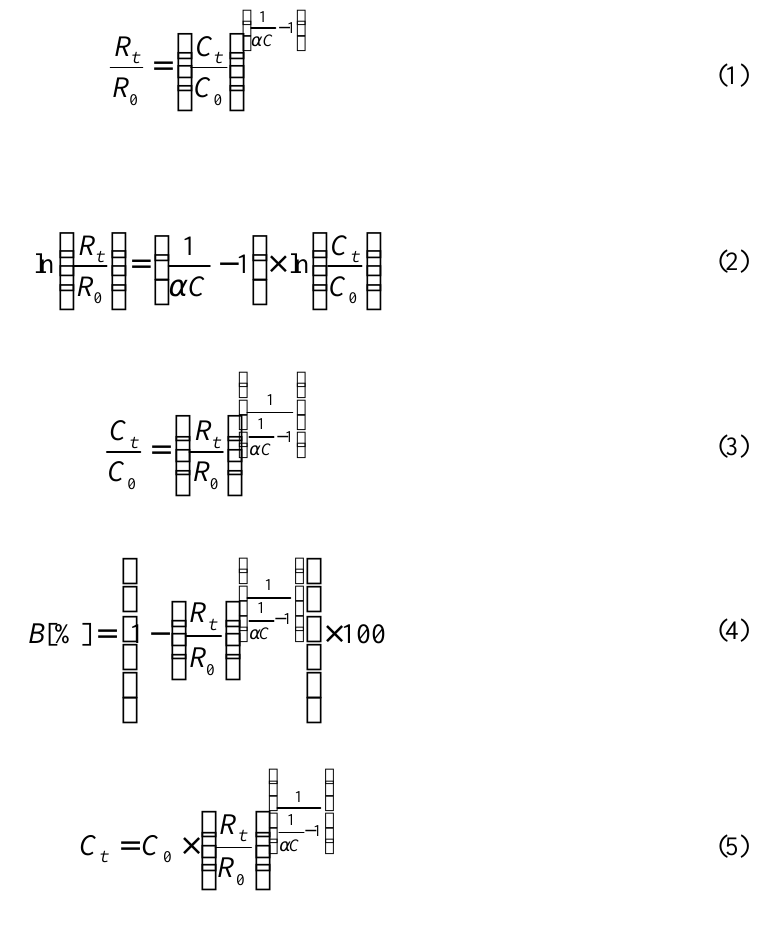
FIGURE 1. Equations used for